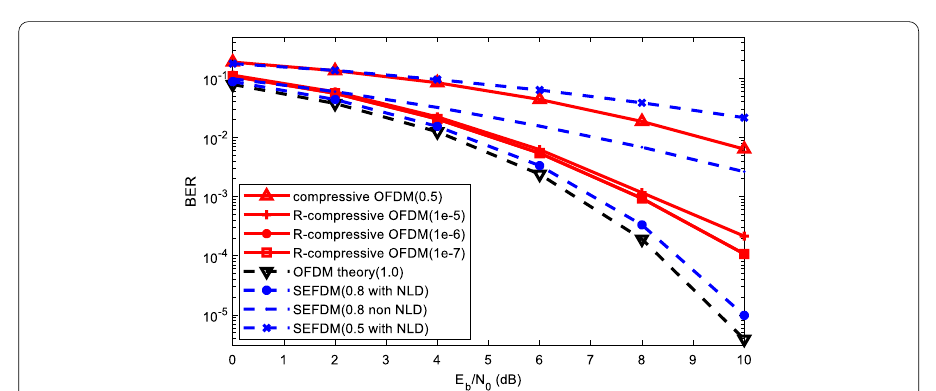
Fig. 8 BER of compressive OFDM with different regularization parameters, OFDM and